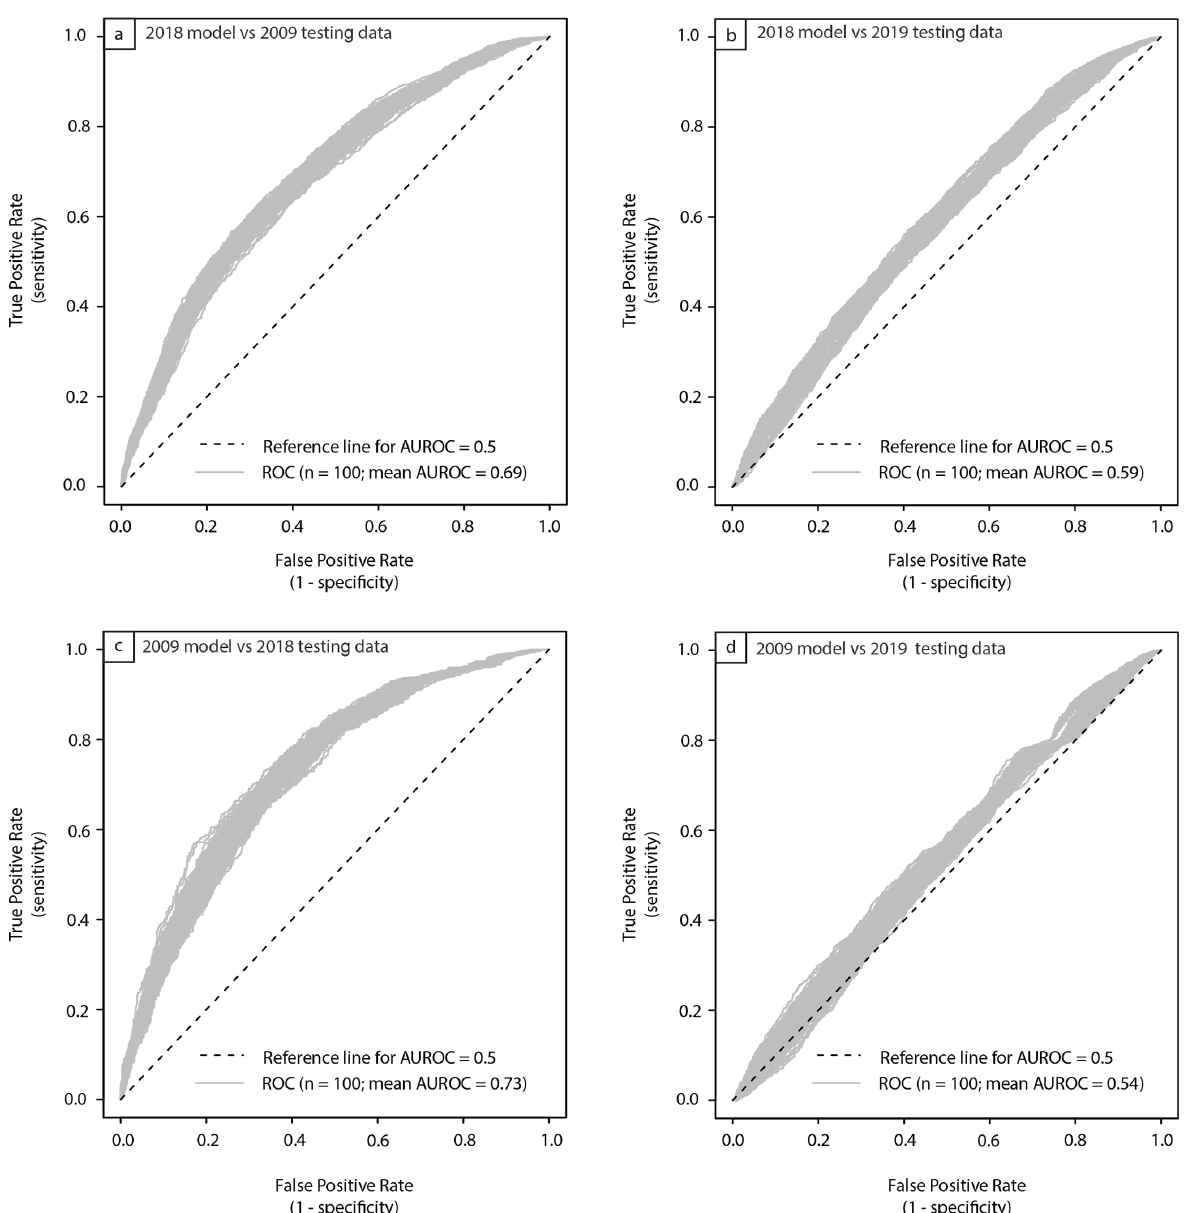
Figure 7. Receiver operator curves (ROCs) showing the performance of (a) the 2018 model classifying independent testing data from 2009, (b) the 2018 model classifying independent testing data from 2019, (c) the 2009 model classifying independent testing data from 2018, and (d) the 2009 model classifying independent testing data from 2019. In each case the reference ROC for a “random” model with 50% accuracy is shown, as is the AUROC value for all